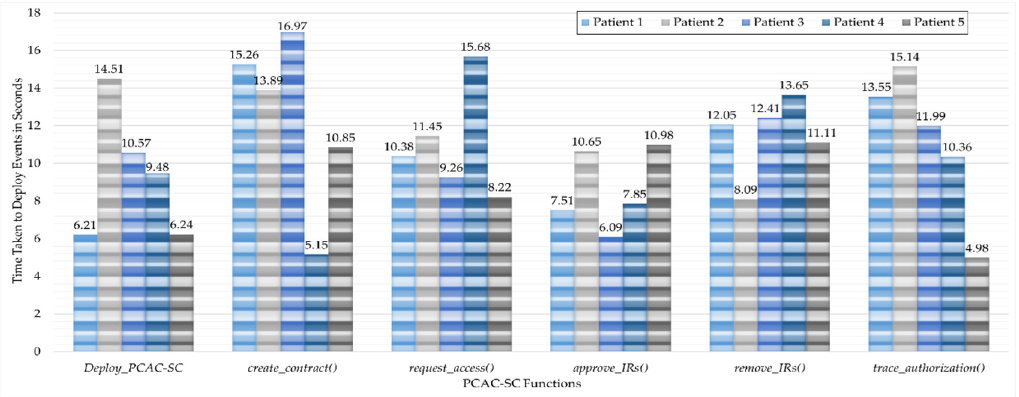
Figure 11. Average Time Taken to Record the PCAC-SC Events by using Five Patients’ Ethereum Address.